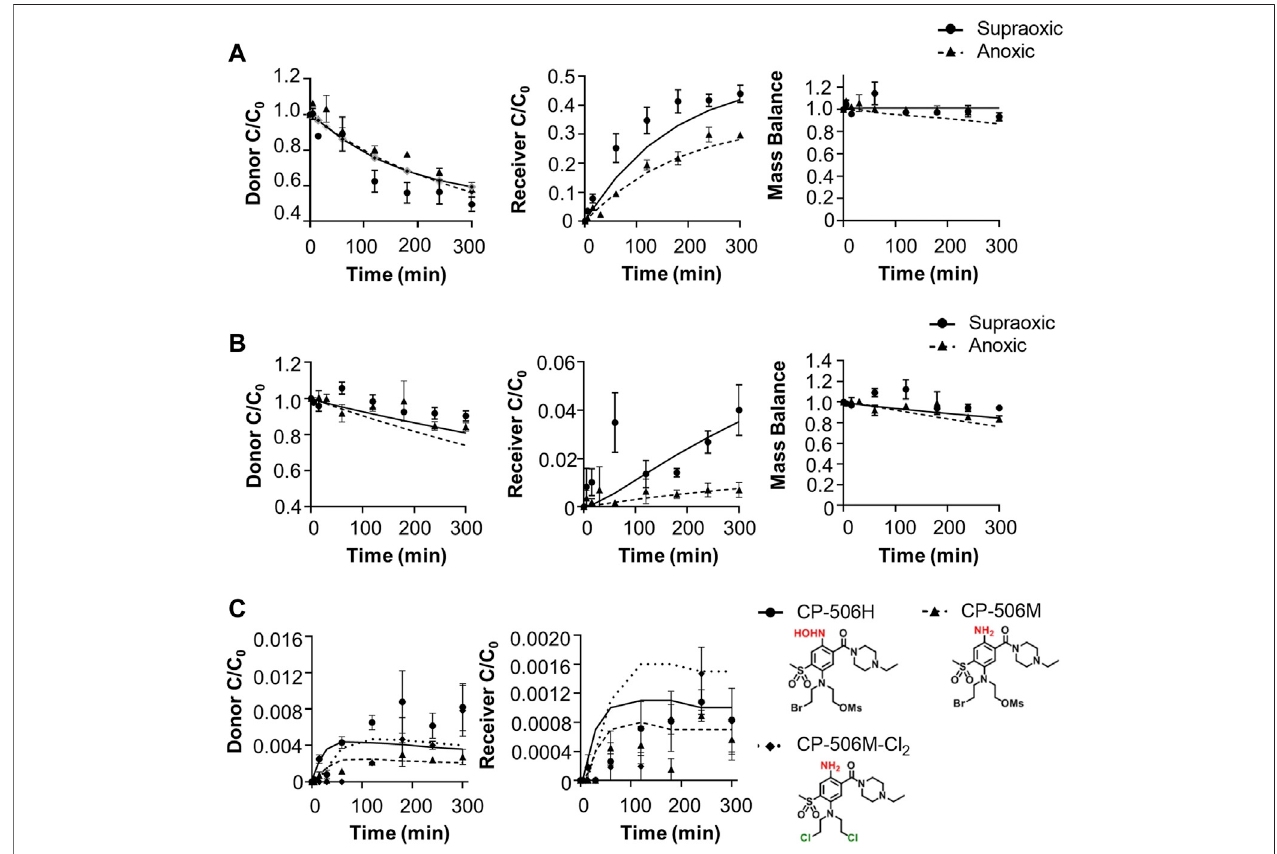
FIGURE 5 | Extravascular transport of CP-506 and its formed metabolites (CP-506H, CP-506M and CP-506M-Cl 2 ) across support membranes with or without a MCL culture. Flux was initiated by the addition of CP-506 (C o (cid:1) 17.4 ± 1.3 µM) and internal standard [ 14 C]-urea into the donor compartment of diffusion chambers maintained under supraoxic(95%O 2 ,5%CO 2 )andanoxic(5%CO 2 ,balN 2 )conditions.Theconcentration-timepro fi leofCP-506inthedonorandreceivercompartmentsofdiffusionchamberswas determined by mass spectrometry. Mass balance was calculated as the sum of the donor and receiver compartments. Lines are the concentrations predicted from the developed(pro)drugtransportmodel.Valuesaremean ± SEMofthreeindependentdiffusionchambers. (A) Concentration-timepro fi leofCP-506acrossbaresupportmembranes (without cells) maintained under supraoxic and anoxic conditions. (B) Concentration-time pro fi le of CP-506 across POR-R MCLs maintained under supraoxic and anoxic conditions. (C) Concentration-time pro fi le for the formed metabolites of CP-506 (CP-506H, CP-506M and CP-506M-Cl 2 ) in POR-R MCLs under anoxic conditions.